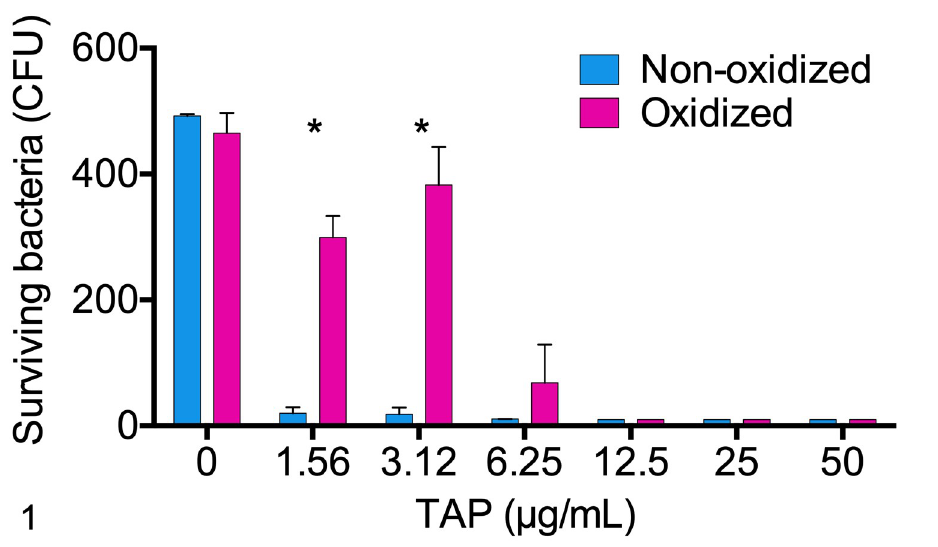
Fig 1. Comparison of the bactericidal activity of non-oxidized and oxidized tracheal antimicrobial peptide (TAP) against Mannheimia haemolytica B158. Serial dilutions of TAP in monobasic sodium phosphate buffer were incubated with M . haemolytica for 1 hour. The preparation was inoculated onto blood agar plates, and colonies were counted the next day. � P < 0.05 (non-oxidized vs oxidized TAP), 2-way ANOVA, n = 3 replicates per group.